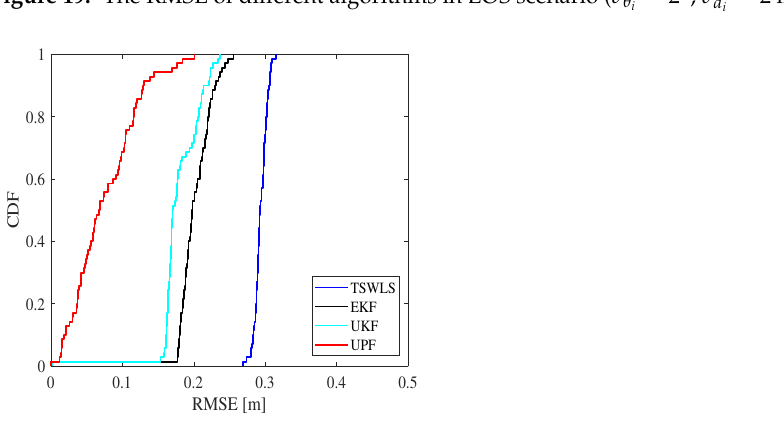
Figure 20. The CDF of RMSE for different algorithms in LOS scenario ( σ θ